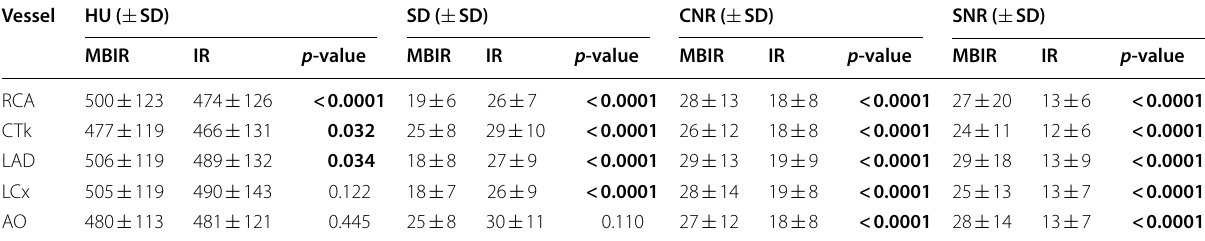
HU Hounsfield Unit, CNR contrast-to-noise ratio, SNR signal-to-noise ratio, RCA right coronary artery, CTk common trunk, LAD left anterior descending artery, LCx left circumflex artery, AO aorta, MBIR model-based iterative reconstruction, IR iterative reconstruction p -values in bold represent statistical significant